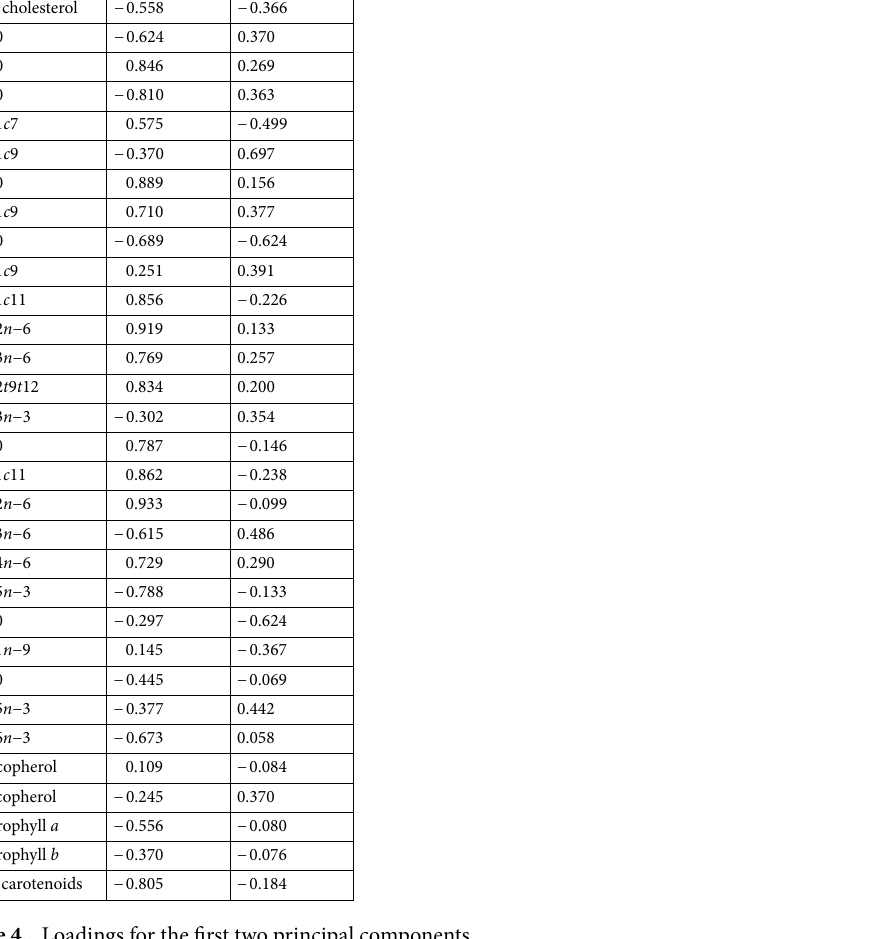
Table 4. Loadings for the first two principal